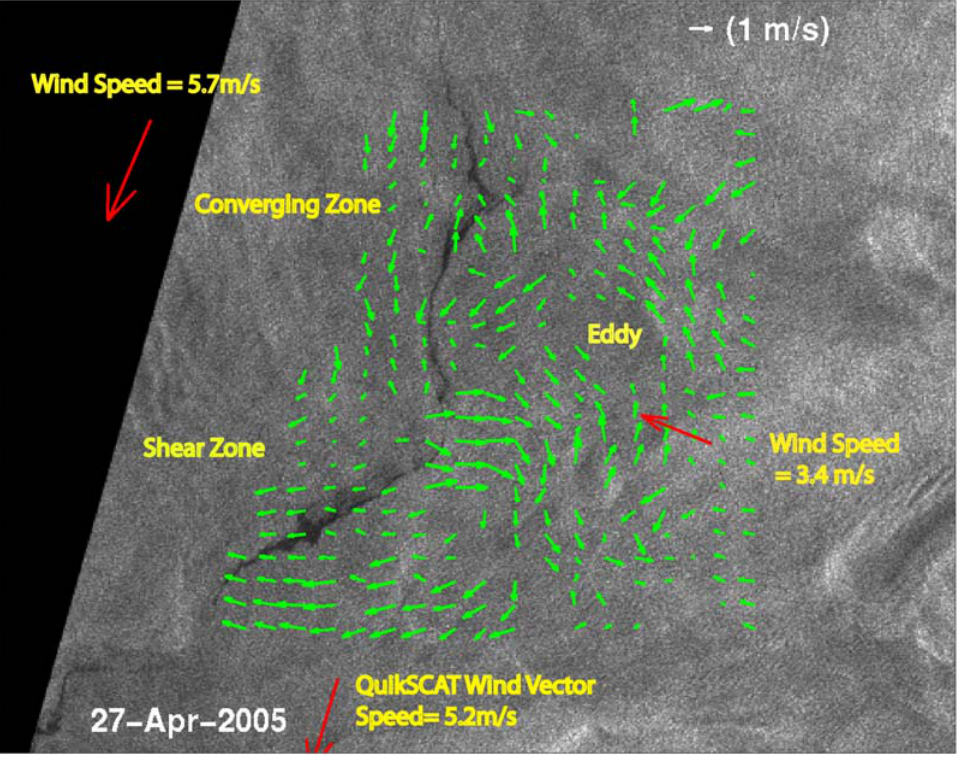
Figure 3. Ocean surface drift (green arrows) derived from ERS-2 and ENVISAT SAR data near the oil slick area (ENVISAT image as background). The surface drift unit of 1 m/s is indicated by a white arrow at the top. The QuikSCAT wind data are shown as red